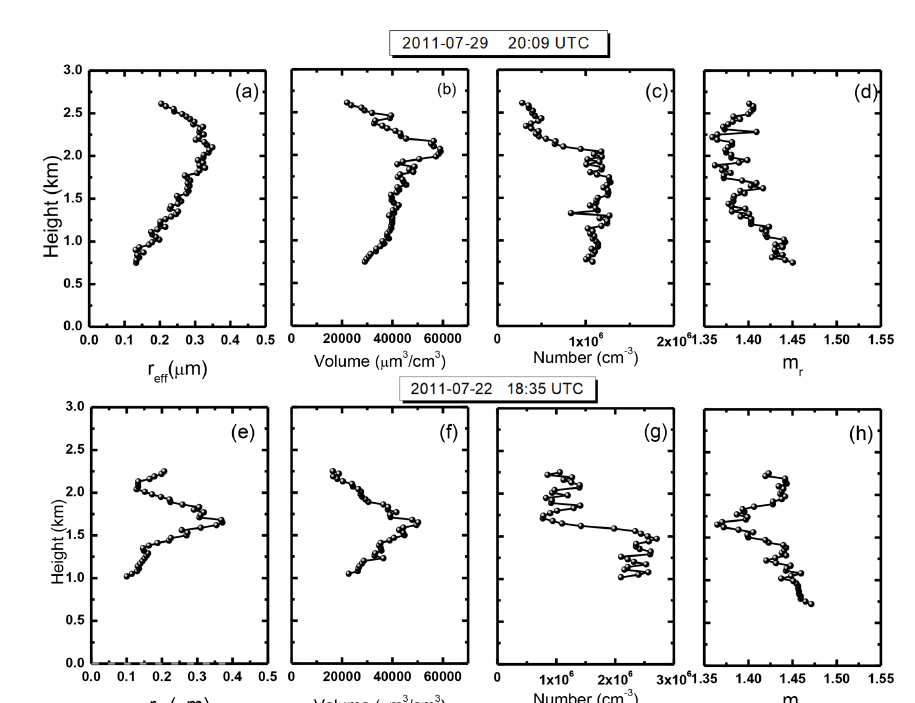
Figure 8. Retrieved effective radius ( r eff ), volume and number concentrations and real part of refractive index ( m r ) from the stand-alone 3 β + 2 α lidar inversion for (a–d) 29 July 2011 and (e–f) 22 July